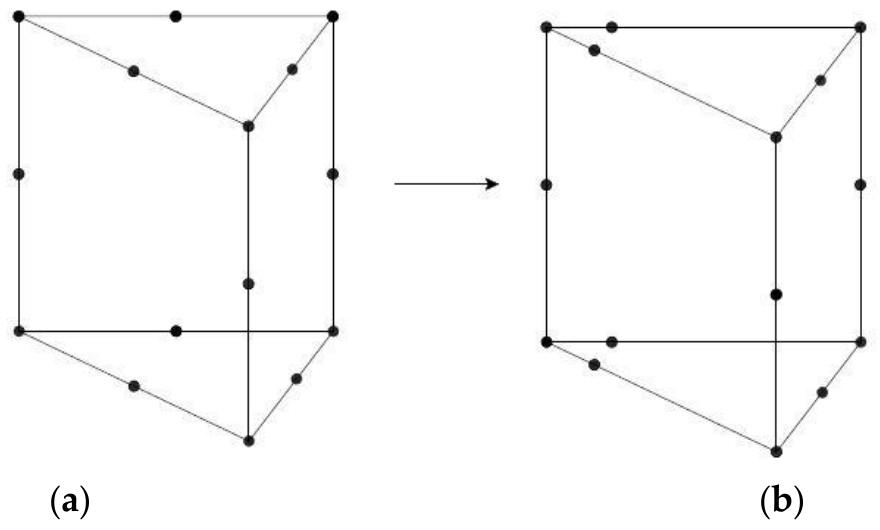
Figure 11. Geometric description of singular elements at crack tip. ( a ) Original element, ( b ) Modi- fied element.